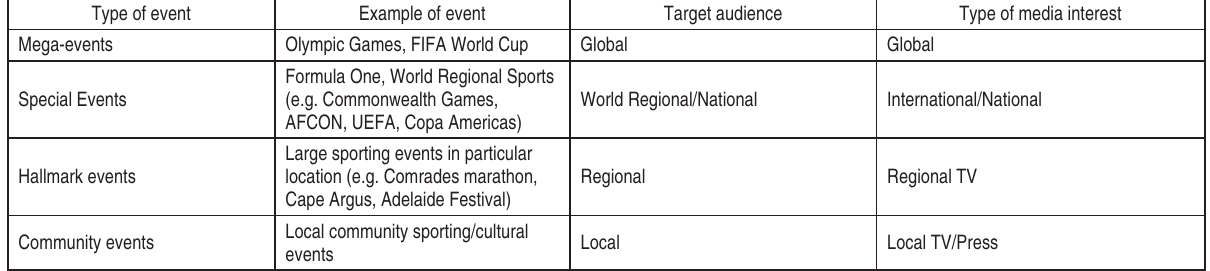
Table 2. Categories of sporting events (adapted from Roche, 2001; Visser, S. D.,